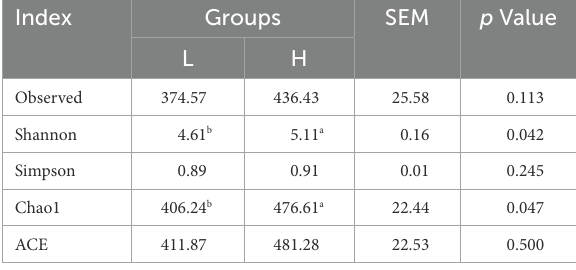
TABLE 5 Rumen microbial richness and diversity